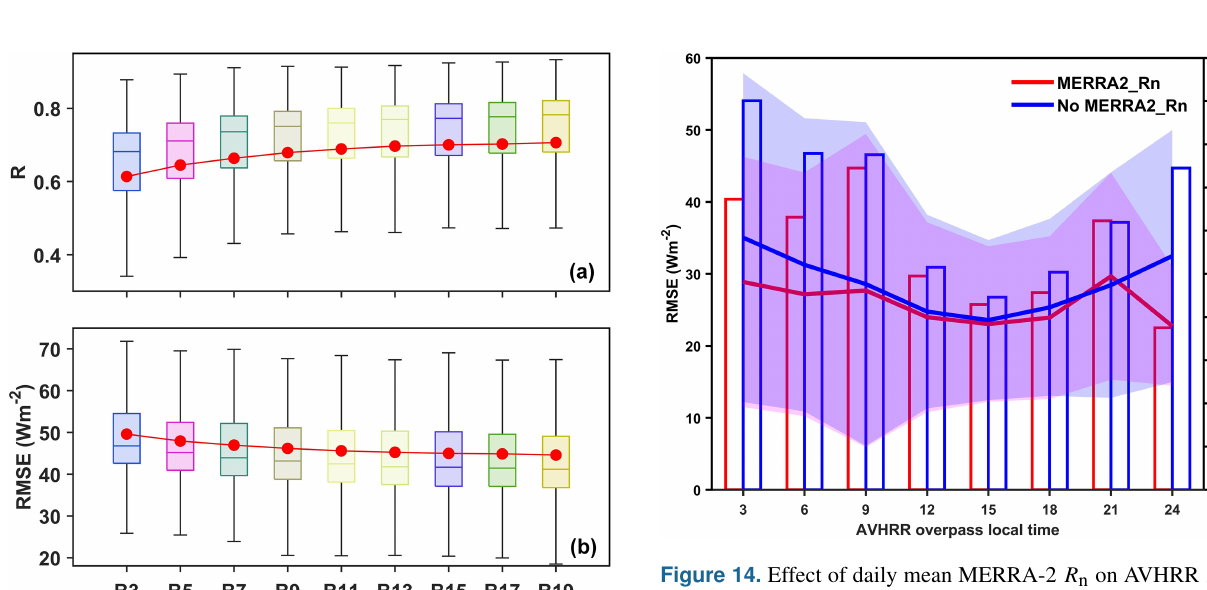
Figure 12. Long-term temporal variation in (a) monthly average R n and (b) monthly R n anomalies for the AVHRR, CERES, GLASS, and MERRA-2 datasets. The shading represents the variation range (standard deviation) of the global monthly mean R n .